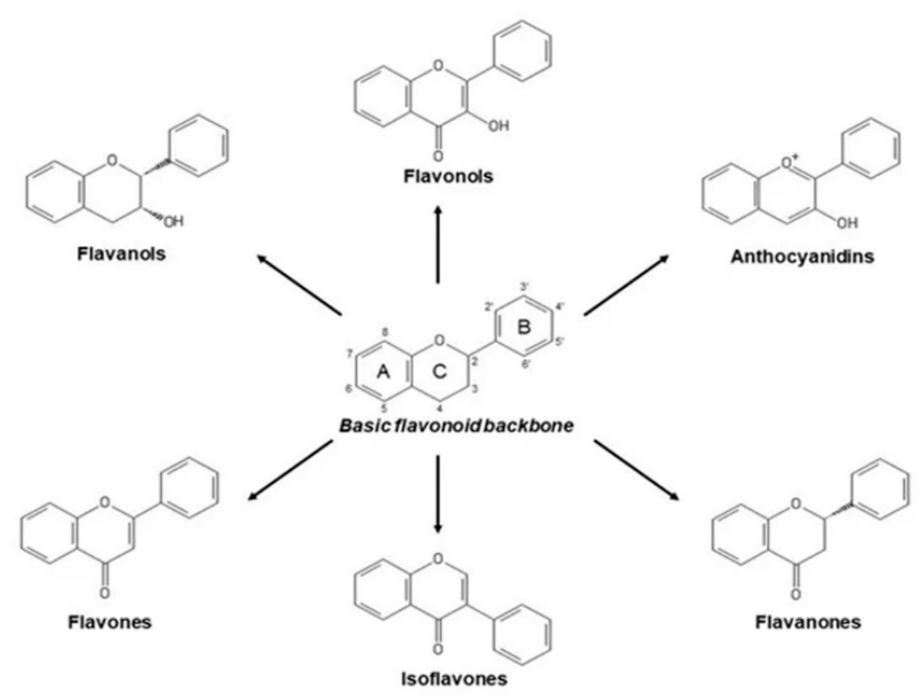
Figure 4. Basic chemical structure of the types of flavonoids. Three rings are considered the backbone of the flavonoid. The oxygen atom is in the first position in the heterocyclic ring labeled as C [92]. O, oxygen; O + , oxygen ion; OH, hydroxyl group; A, C, B, rings